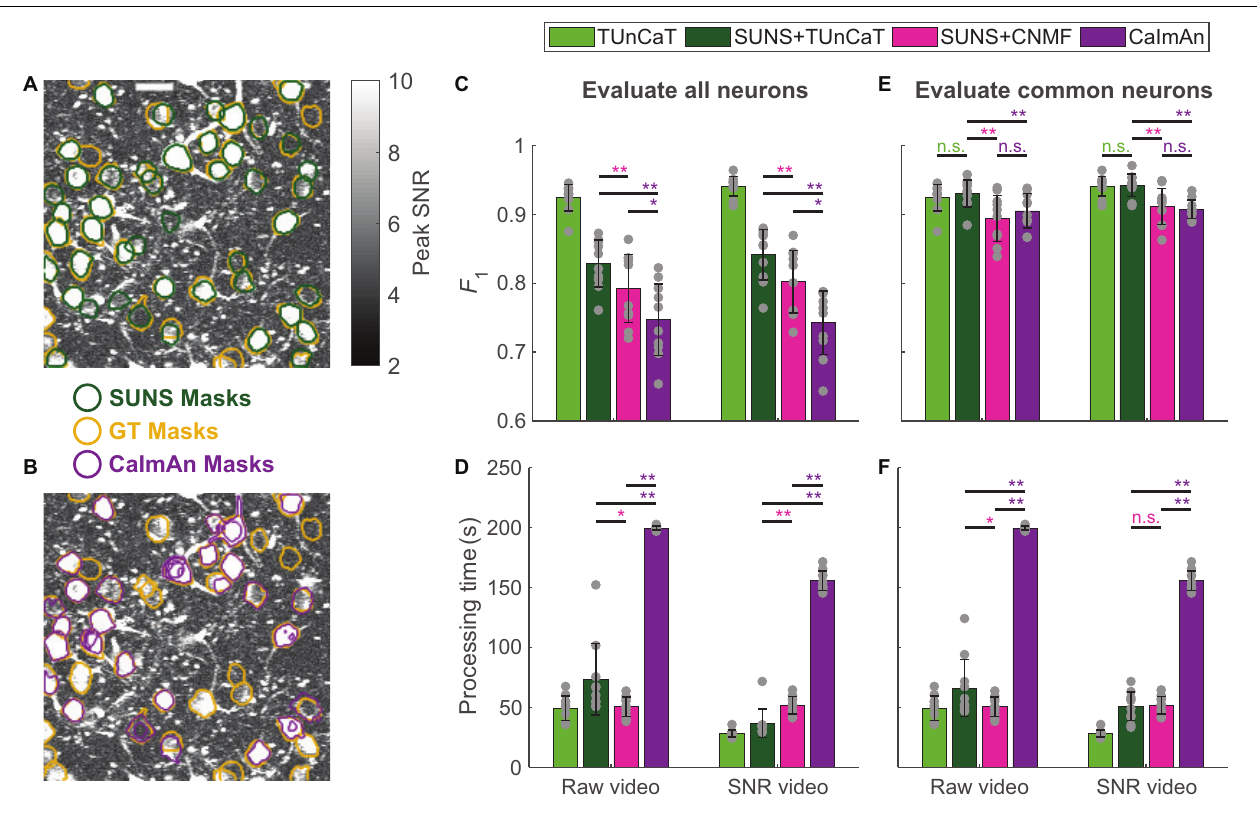
FIGURE 3 | Two-step spatial segmentation and temporal unmixing was more accurate than one-step spatiotemporal unmixing. We also showed the results of applying TUnCaT on GT neurons as a reference, whose processing time did not include manual neuron segmentation. (A,B) The SUNS masks matched the GT masks better than the CaImAn masks. The neurons in an example ABO video found by manual labeling as GT (yellow) and (A) SUNS (dark green) or (B) CaImAn (purple) are overlaid on top of the imaging data. The grayscale images are the projection of the maximum pixel-wise SNR (Scale bar: 20 µ m). (C) The F 1 scores of CaImAn during 10-round cross-validation were significantly lower than that of SUNS + TUnCaT and SUNS + CNMF both when processing raw videos and when processing SNR videos (* p < 0.05, ** p < 0.005, two-sided Wilcoxon signed-rank test, n = 10 videos; error bars are standard deviations). We evaluated the accuracy by considering transients from all ground truth and algorithm-generated neurons. The gray dots represent scores for the test data on each round of cross-validation. (D) The processing time of CaImAn was significantly longer than SUNS + TUnCaT and SUNS + CNMF both when processing raw videos and when processing SNR videos (* p < 0.05, ** p < 0.005, two-sided Wilcoxon signed-rank test, n = 10 videos; error bars are standard deviations). We used the α of TUnCaT that optimized the F 1 scores considering transients from all ground truth and algorithm-generated neurons. The gray dots represent the processing times for the test data on each round of cross-validation. (E) The F 1 scores of SUNS + TUnCaT during 10-round cross-validation were significantly higher than that of CaImAn and SUNS + CNMF both when processing raw videos and when processing SNR videos (** p < 0.005, n.s. - not significant, two-sided Wilcoxon signed-rank test, n = 10 videos; error bars are standard deviations). We evaluated the accuracy by considering only neurons spatially segmented by all methods. The gray dots represent scores for the test data on each round of cross-validation. (F) The processing time of CaImAn was significantly longer than SUNS + TUnCaT and SUNS + CNMF both when processing raw videos and when processing SNR videos (* p < 0.05, ** p < 0.005, n.s. - not significant, two-sided Wilcoxon signed-rank test, n = 10 videos; error bars are standard deviations). We used the α of TUnCaT that optimized the F 1 scores considering only neurons spatially segmented by all methods. The gray dots represent the processing times for the test data on each round of